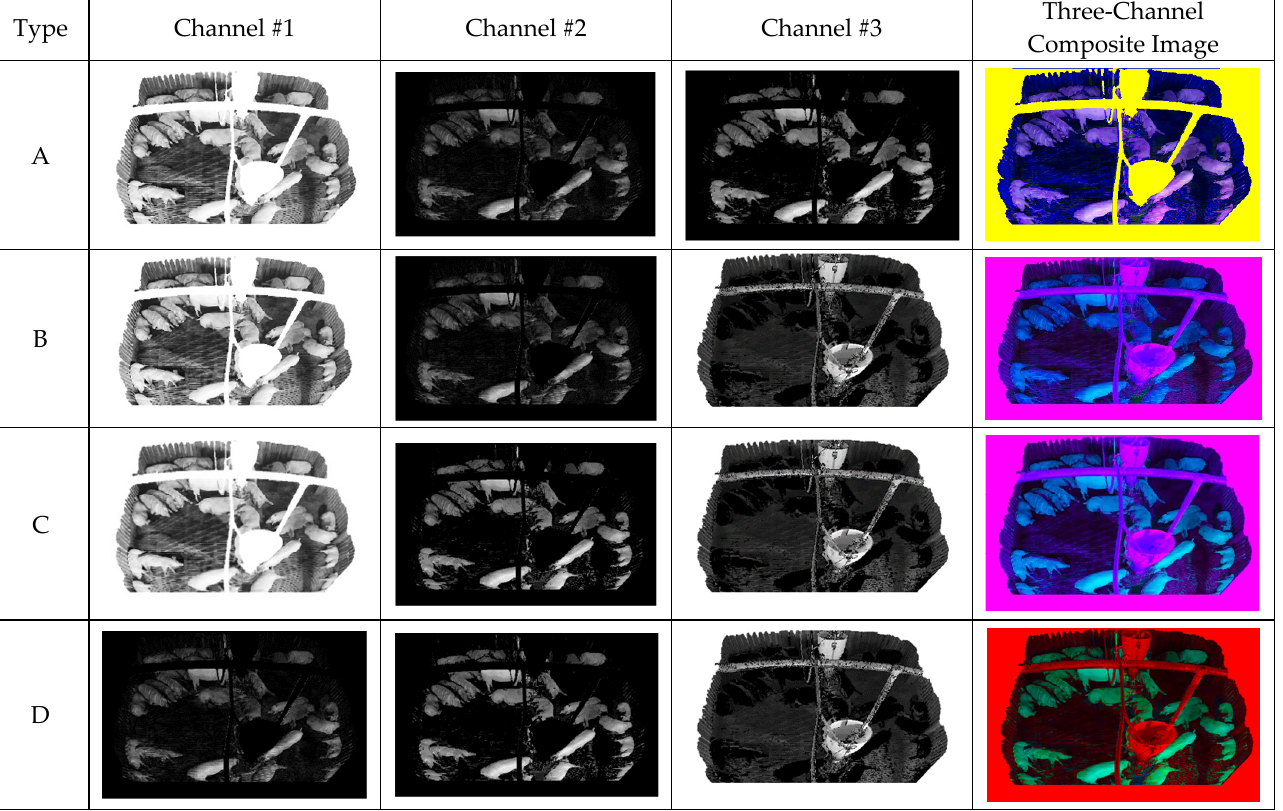
Figure 13. Combinations of 3-channel composite images.